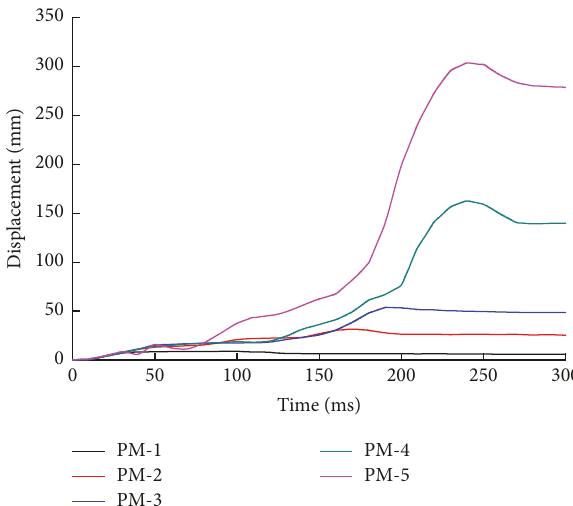
Figure19:Displacementtime-historycurvesunderdifferentimpact